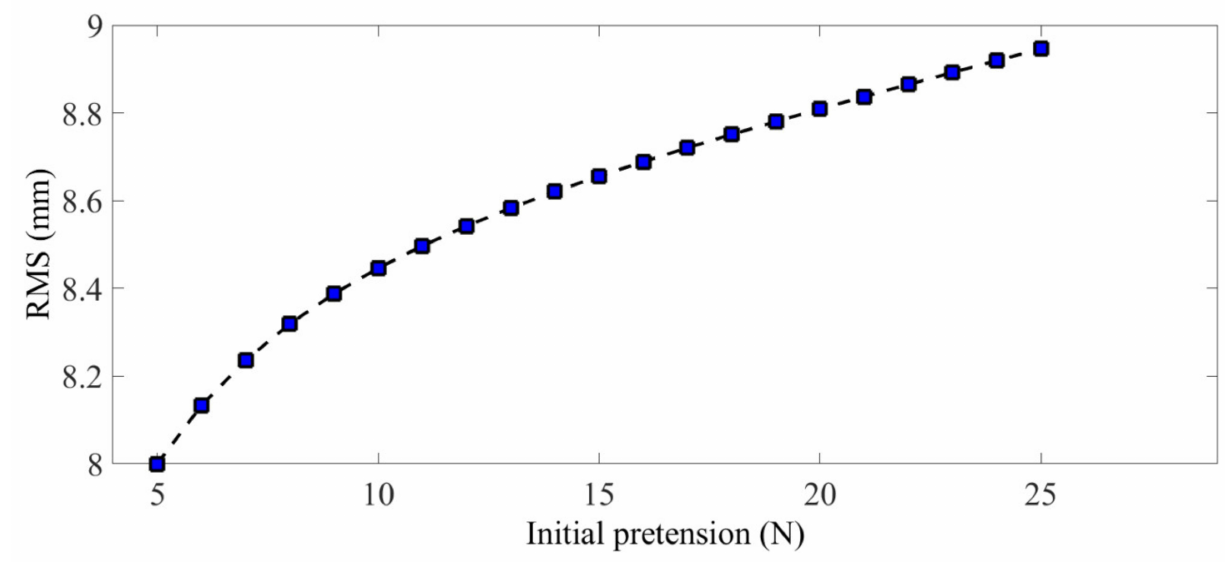
Figure 22. The variation trend of the accuracy of the antenna reflector under different